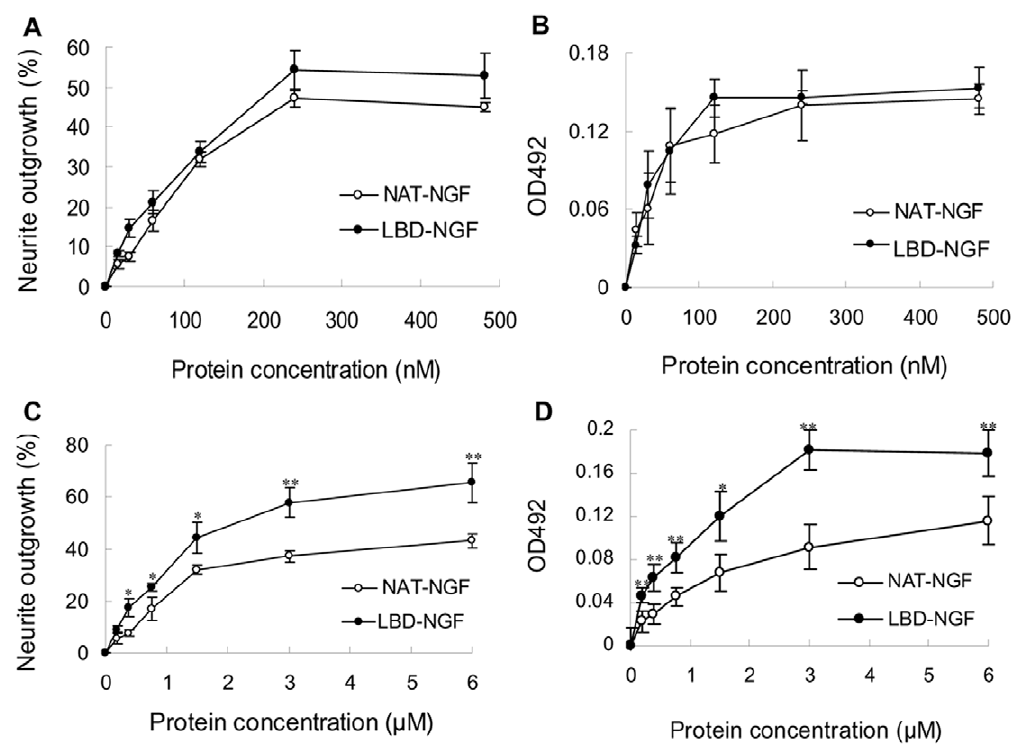
Figure 2. Bioactivity comparison of NAT-NGF and LBD-NGF invitro . (a) Effect of NAT-NGF and LBD-NGF on neurite outgrowth in PC12 cells. (b) Effect of NAT-NGF and LBD-NGF on cell survival in PC12 cells by MTT assay. (c) Percentage of PC12 cells with neurite outgrowth on laminin stimulated by NAT-NGF and LBD-NGF. (d) PC12 cell survival on laminin stimulated by NAT-NGF and LBD-NGF was determined by MTT assay. n=6, *, P , 0.05, **, P , 0.01, determined by two-tailed student’s t